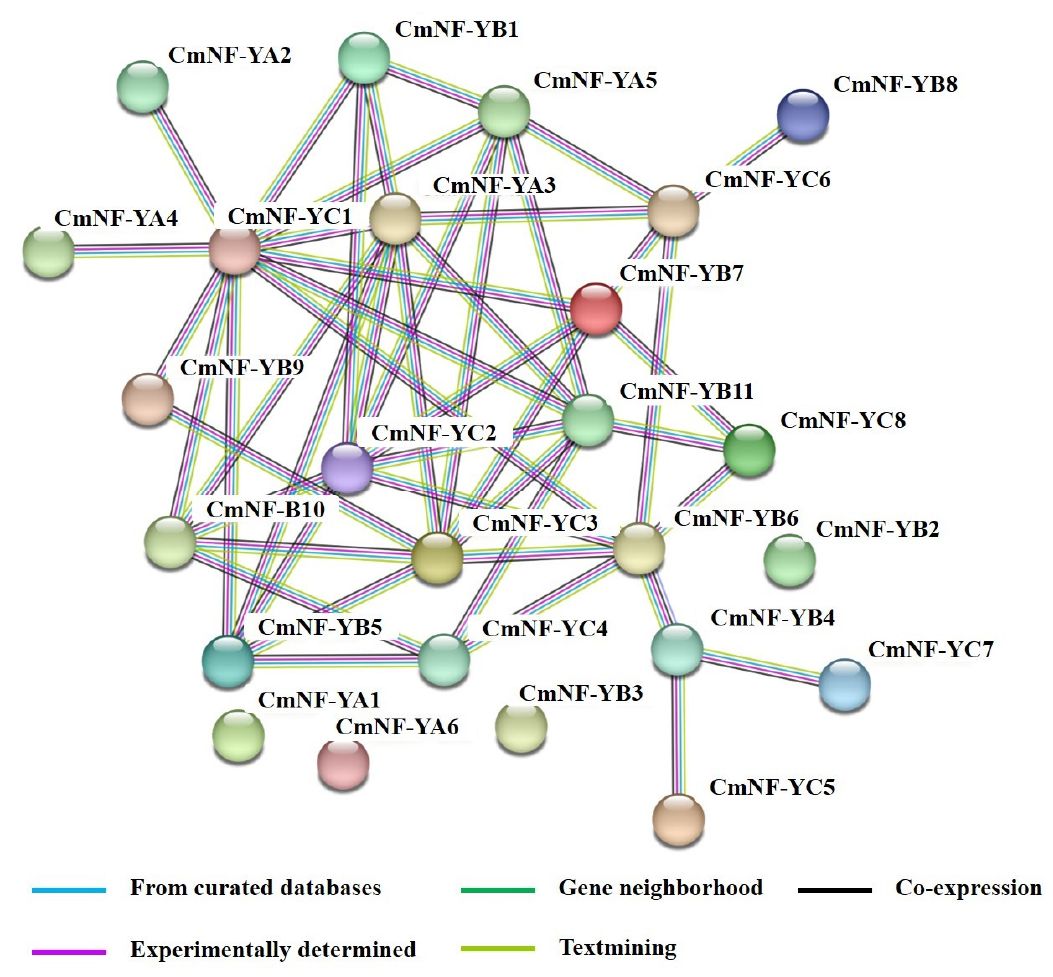
Figure 6. Protein–protein association network analysis of CmNF-Ys.